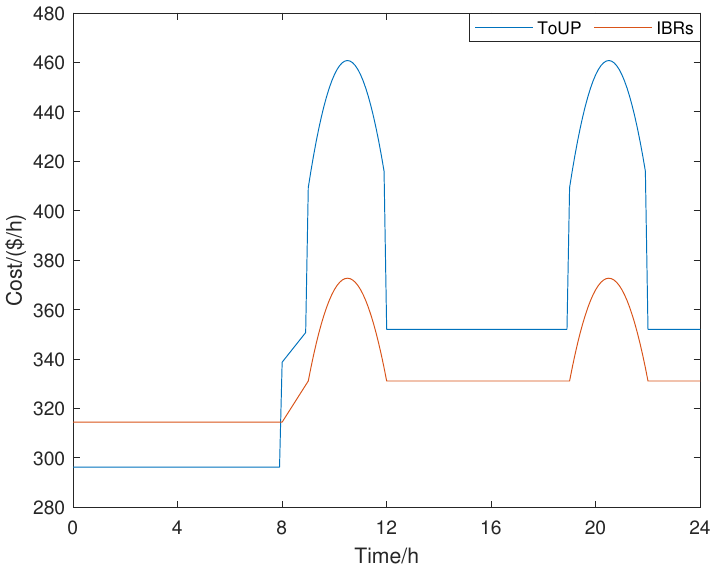
Figure 10. Cost at ToUP and IBRs.